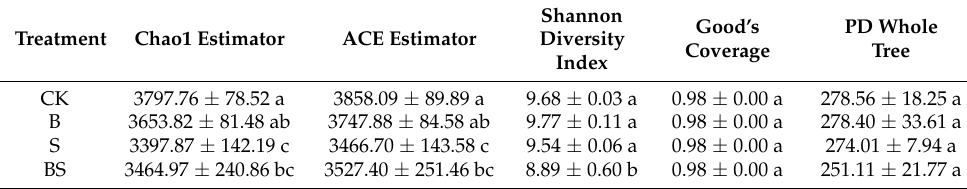
Table 2. Effects of different treatments on the diversity indices of bacteria.